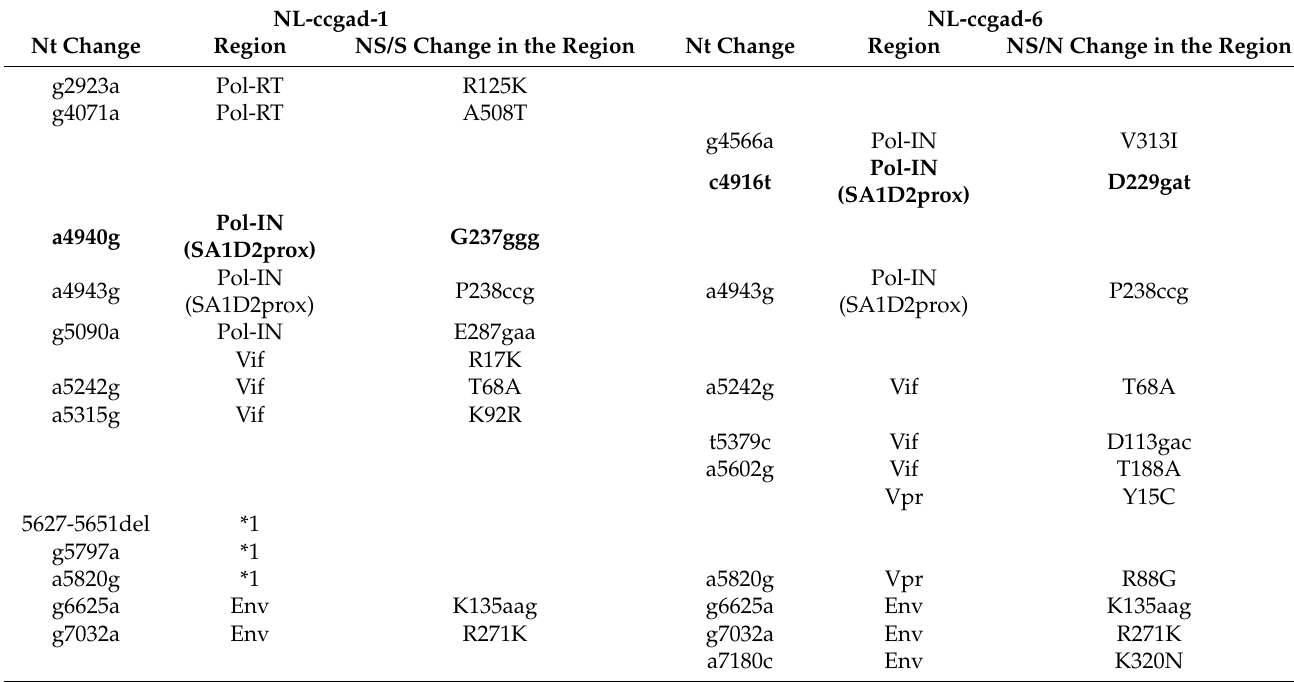
Figure 5. Characteristics of viral clones constructed from adapted NL-P238ccg. ( A ) Growth kinetics. Viruses prepared from HEK 293T cells transfected with the indicated pro-viral clones were inoculated into H9 cells (1 × 10 4 RT units/10 5 cells). Virus replication was monitored by the virion-associated RT activity in the culture supernatants. This experiment was performed once to select viral clones that have the ability to grow in cells. Viral replication kinetics of WT NL4-3 and a parental NL-P238ccg are presented in both panels for easy comparison. ( B ) Vif expression levels. Western blotting analysis was carried out as described in Figure 3B. Numbers correspond to those for the adapted clones shown in panel ( A ). Representative data from two independent experiments are shown. Table 4. Mutations found in adapted clones with decreased Vif expression levels compared to that in the NL-P238ccg clone.